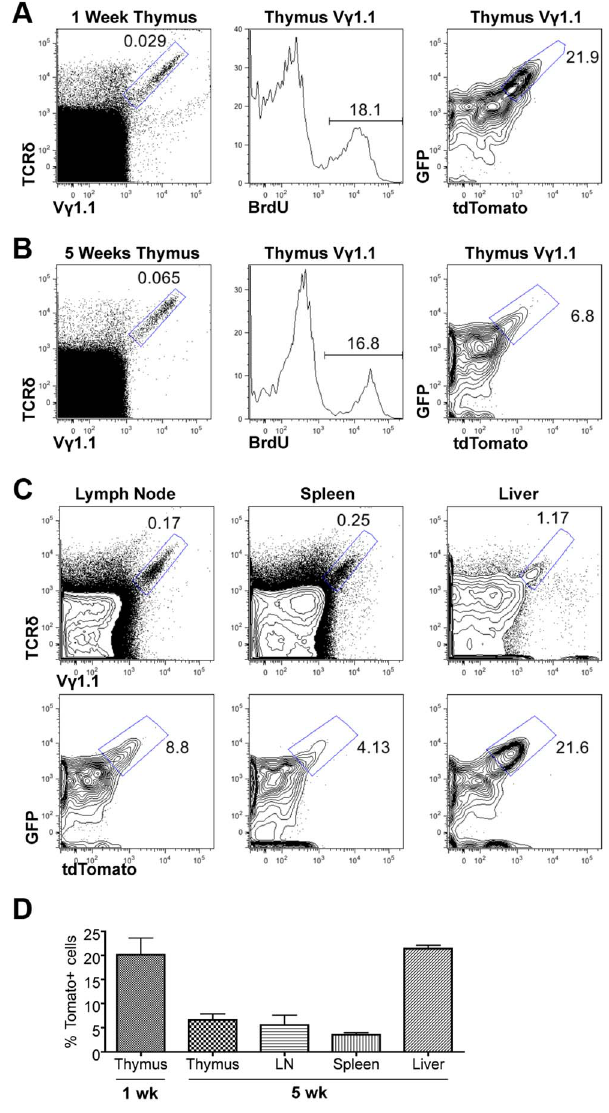
Figure 3. Assessing proliferation frequency and history of V c 1.1 T cells. (A) Representative FACS plots of thymic V c 1.1 cd T cells from one-week old lckCre;Tlox neonates. V c 1.1 cells were identified in the gated area of TCR d and V c 1.1 doubly stained total thymocytes (left) and used in subsequent display of BrdU incorporation (middle) and GFP/dtTomato expression (right). (B) Analyses of 5-week old mice as described in (A). (C) Analysis of V c 1.1 T cells present in lymph node (left), spleen (middle), and liver (right) of 5-week old mice as described in (B). Frequency of tdTomato expression was shown in the contour plot below each dot plot. (D) Summary of tdTomato expression frequency in V c 1.1 T cells obtained from (A–C). Sample sizes are three for one-week old and three for 5-week old